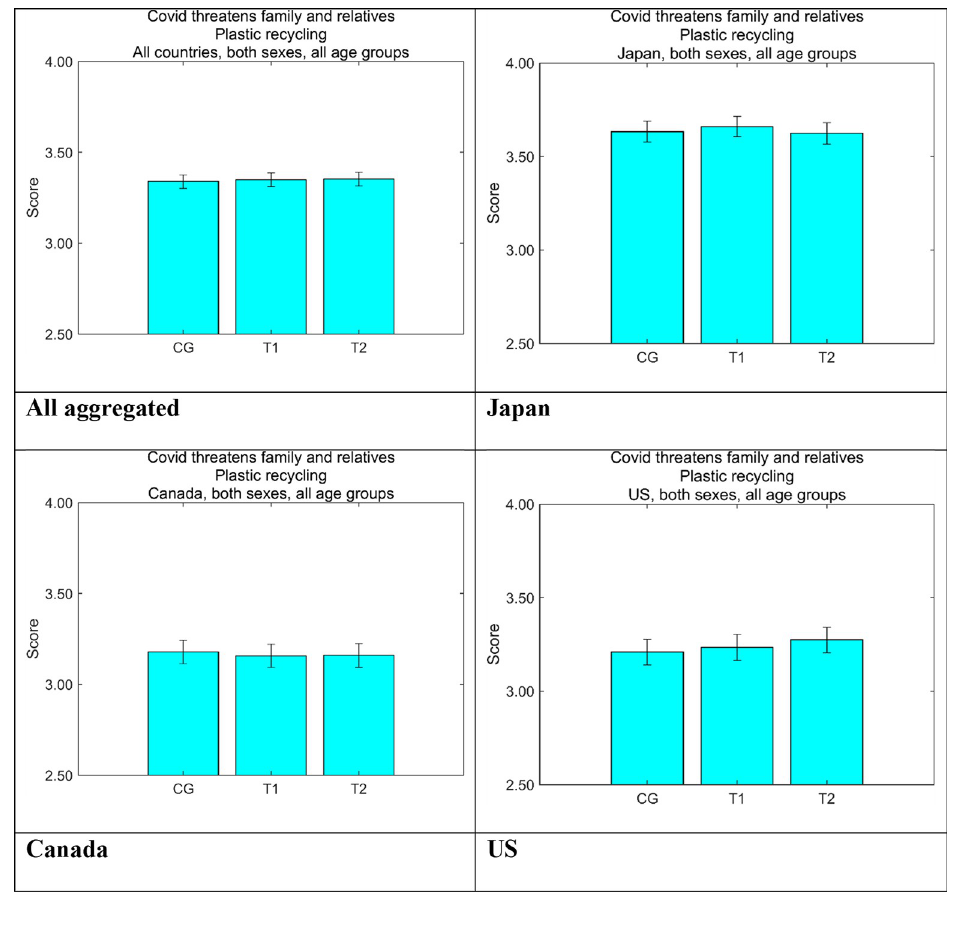
Fig 10. Perception by group that COVID-19 threatens the respondents’ family and relatives. Higher values on the vertical axis indicate higher perceived danger. Error bars show 95% confidence intervals. CG, control group; T1, treatment group 1; T2, treatment group